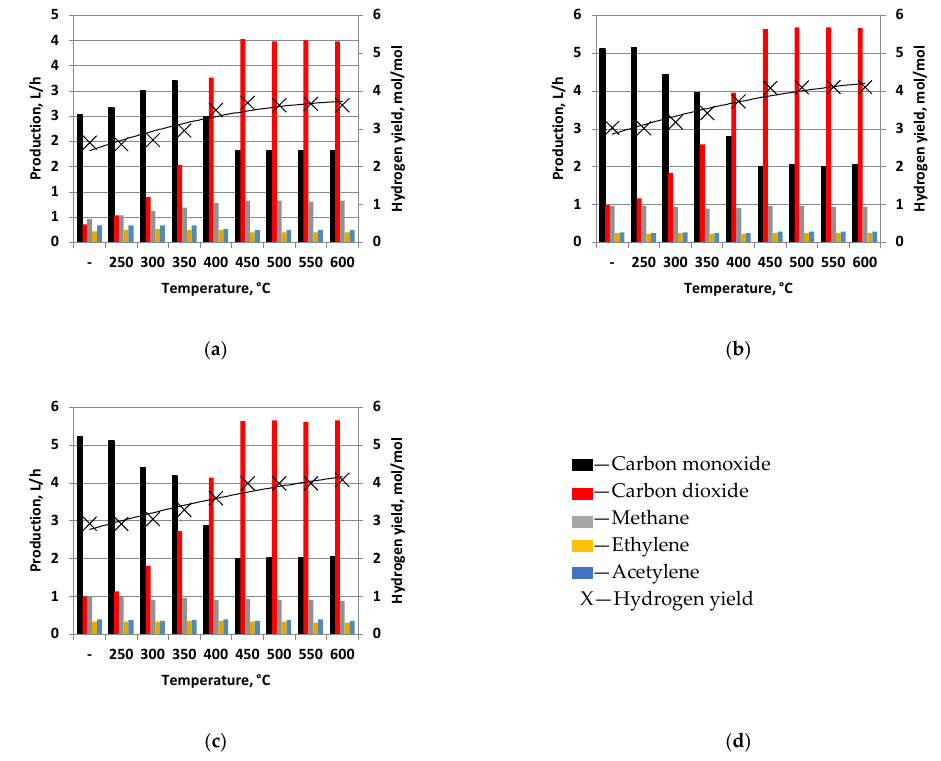
Figure 4. The influence of the catalyst temperature on various compounds and hydrogen yield. Discharge power: ( a ) 15 W; ( b ) 25 W; ( c ) 35 W. ( d ) Legend for charts. Even stable substrates can be dissociated with high efficiency in plasma, and chemi- cal reactions involving them can be initiated. On the other hand, collisions with electrons that initiate chemical reactions in plasma are not very selective, and plasma processes are usually non-selective. In contrast, catalytic processes are selective, but they are sensitive to the temperature and purity of the substrates. There was a negligible amount of ethylene and acetylene in the products obtained on the cobalt catalyst [23]. On the other hand, in the spark discharge, the production of these hydrocarbons was many times greater [10,12]. The introduction of the catalyst behind the plasma zone did not limit the conversion of ethanol to ethylene and acetylene. The production of hydrocarbons changed with the change in discharge power. On the other hand, the catalyst bed temperature slightly in- fluenced the production of hydrocarbons. The effect was visible only at the lowest dis- charge power, i.e., 15 W. For this power, CH 4 production increased from 0.47 to 0.83 L/h with the temperature increase to 450 °C and remained at this level despite further temper- ature increases, while the production of C 2 H 2 decreased from 0.34 to 0.25 L/h as the tem- perature increased to 450 °C and remained at this level despite further temperature in- creases. C 2 H 4 production reached the maximum value (0.27 L/h) at the catalyst bed tem- perature of 300 °C, and from 450 °C, the production of C 2 H 4 did not change and amounted to 0.2 L/h. Hydrogen production from ethanol at a discharge power of 15 W was already relatively high. On the other hand, the production of hydrogen from methanol in the plasma-catalytic reactor at 15 W was small [19]. These processes differed in the catalyst,